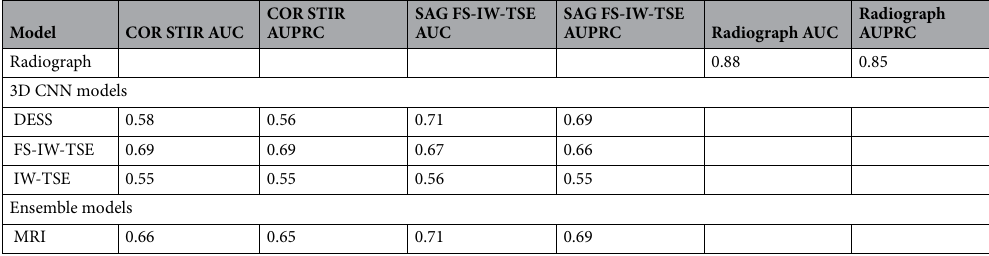
Table 4. Receiver operator characteristic analysis with areas under the curve (AUC) and area under the precision-recall curve (AUPRC) evaluating the diagnostic performance of the models to predict total knee replacement (TKR) using the external testing group in the MOST database for all knees combined. 3D Three-dimensional, CNN Convolutional neural network, CI Confidence interval, DESS Sagittal fat-suppressed three-dimensional dual-echo in steady state, FS-IW-TSE Sagittal fat-suppressed intermediate-weighted turbo spin-echo, IW-TSE Coronal intermediate-weighted turbo spin-echo, COR STIR Coronal short tau inversion